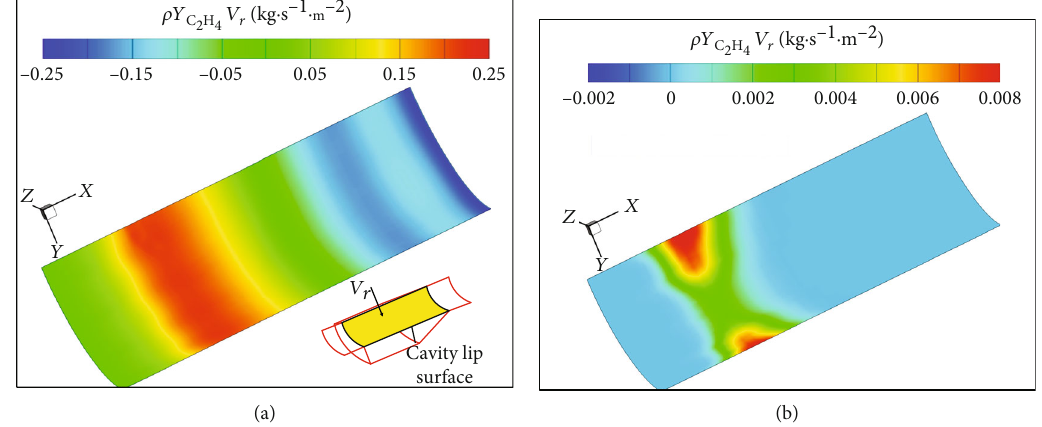
Figure 6: The cavity fuel mass exchange rate of the (a) nonreacting and (b) reacting fl ow fi elds of case-22.5; the cavity lip surface is displayed as the yellow surface in the schematic diagram in